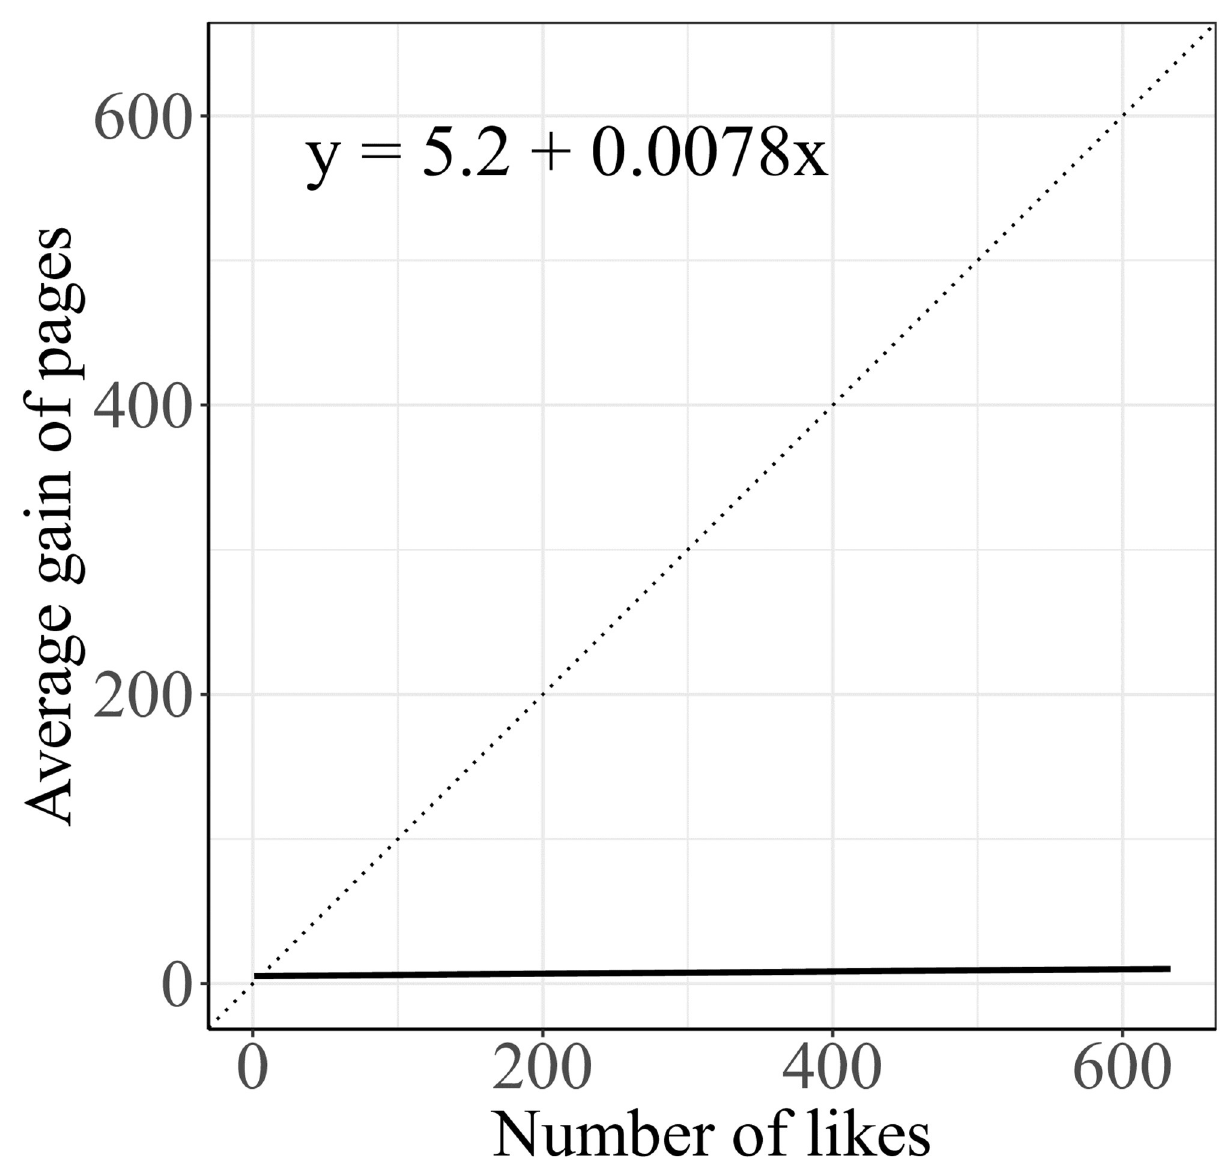
Fig 2. Average gain of pages for each new like of the user. The average gain of pages is displayed by means of a linear regression with equation y = 5.2 + 0.0078 x and r 2 = 0.348. The dotted line represents the case of linear growth.